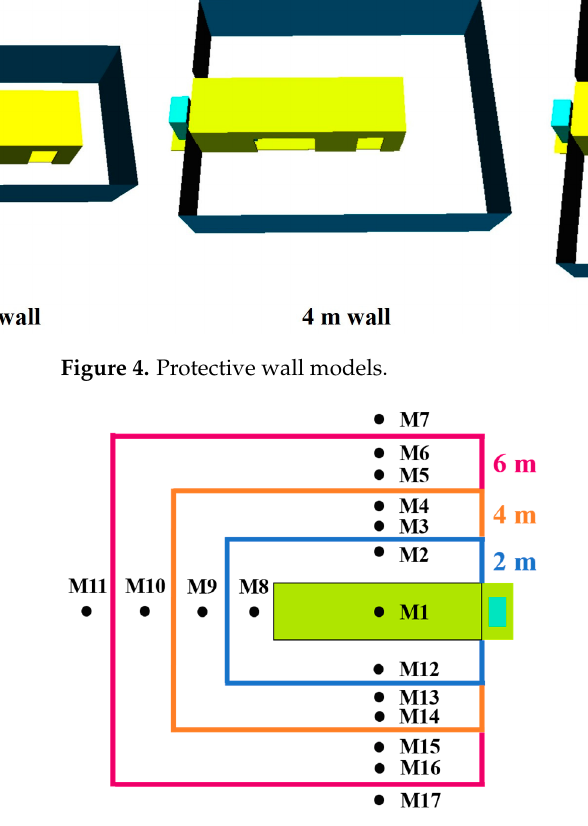
Figure 5. Monitoring point locations.